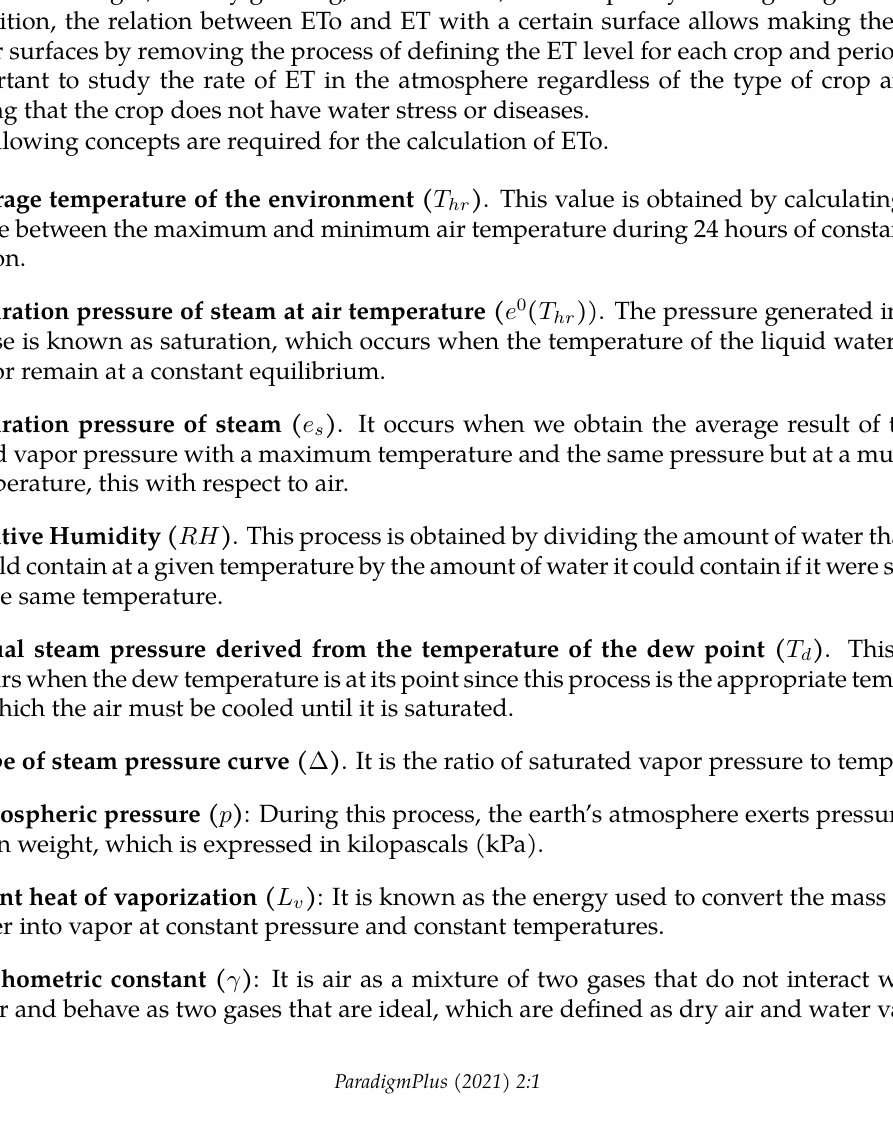
Table 1: Factors influencing ET Factor Description Climatic variables Radiation, air temperature, atmospheric humidity, and wind speed. Crop To estimate evapotranspiration, the type of crop used and the stage of development in which it is found must be taken into account. Ambient conditions The inadequate use of essential fertilizers, the para- sites found in the soil, and the decrease in its fertility limit the correct development of the